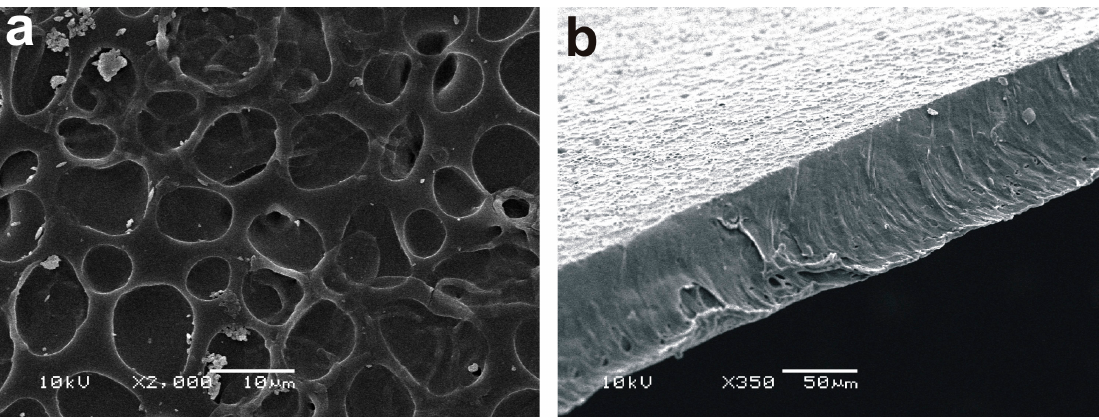
Figure 1. Images of a typical pristine Polyurethane film prepared by casting: ( a ) top scanning electron microscopy (SEM) image and ( b ) SEM cross-section image.